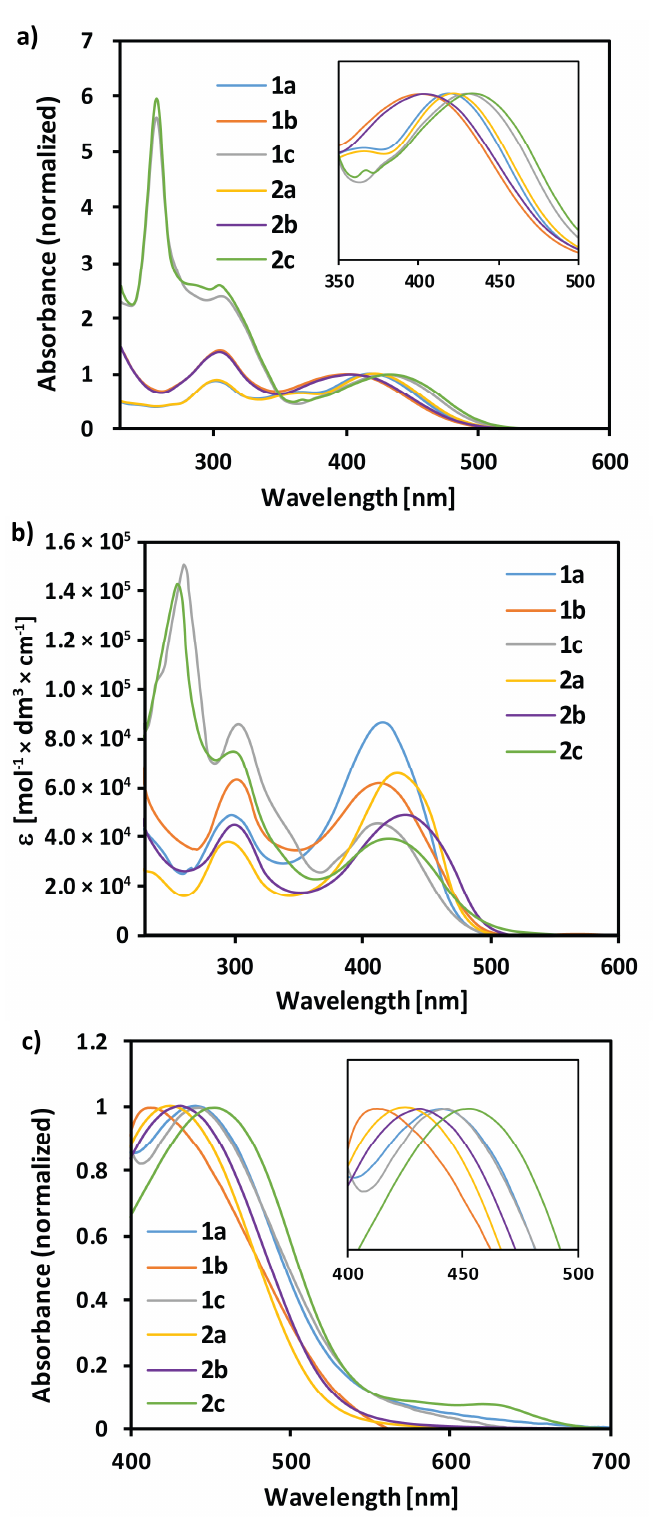
Figure 4. Absorption spectra of 1a – 2c ( a ) in DCM (normalized, inset: zoom on the visible absorption range); ( b ) in EtOH; ( c ) adsorbed on TiO 2 (normalized, inset: zoom on the visible absorption range).